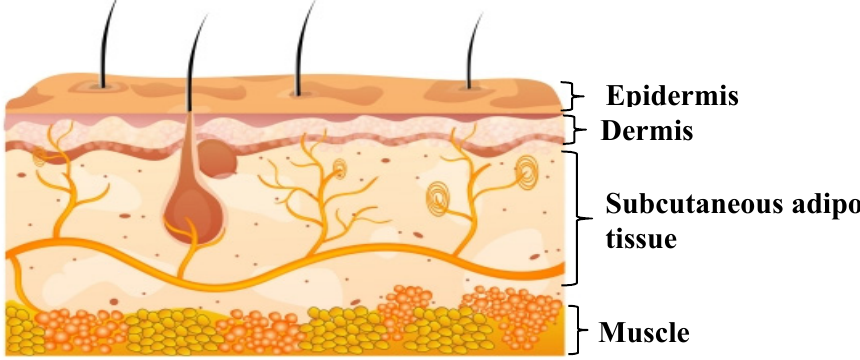
Figure 2. Anatomy of the skin. Credit: Image courtesy of digital art at FreeDigitalPhotos.net.